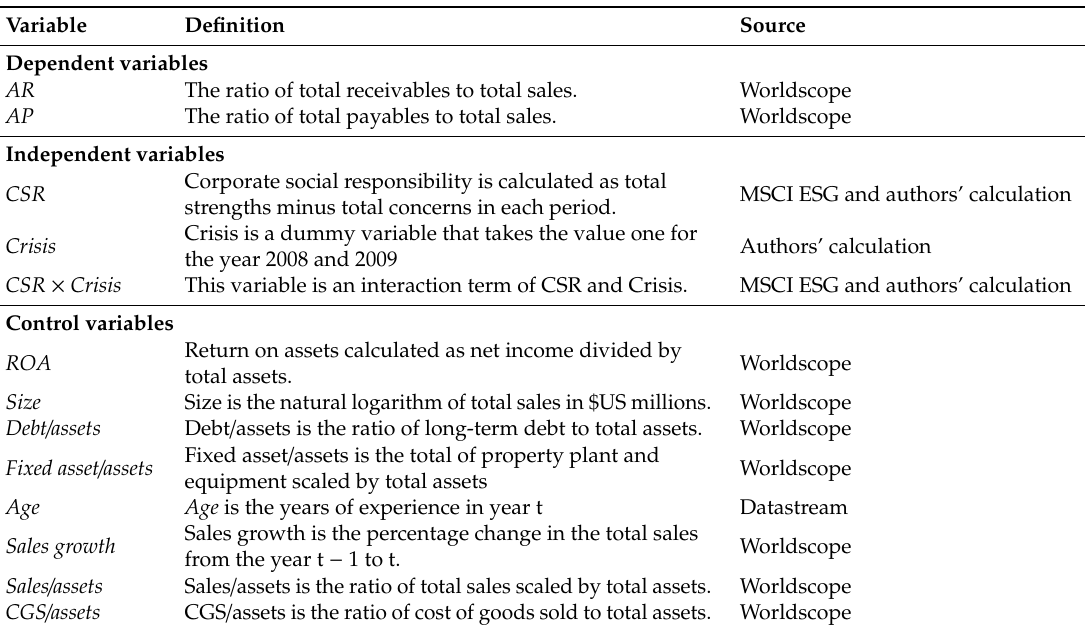
Table A1. Definitions and sources of